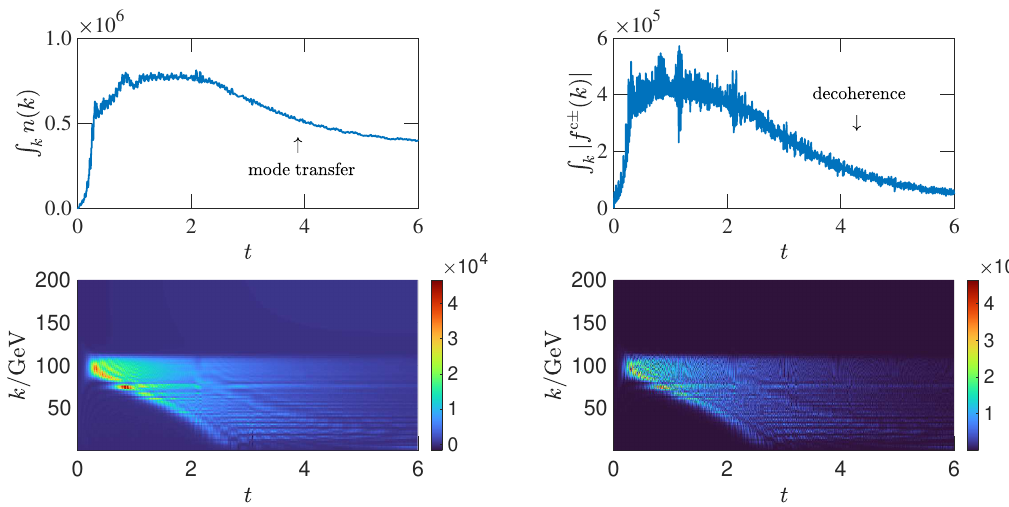
Figure 9 . Shown are the evolution of the number density (left) and the modulus of the coherence functions (right). In the upper panels the quantities are integrated over momentum. We used the same parameters as in figure 5, except for non-zero friction coefficients c i = 0 . 6 GeV in the collision integrals with thermal equilibrium